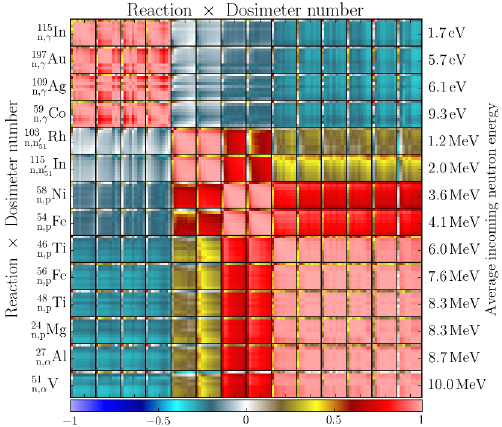
4 Dosimeter correlations